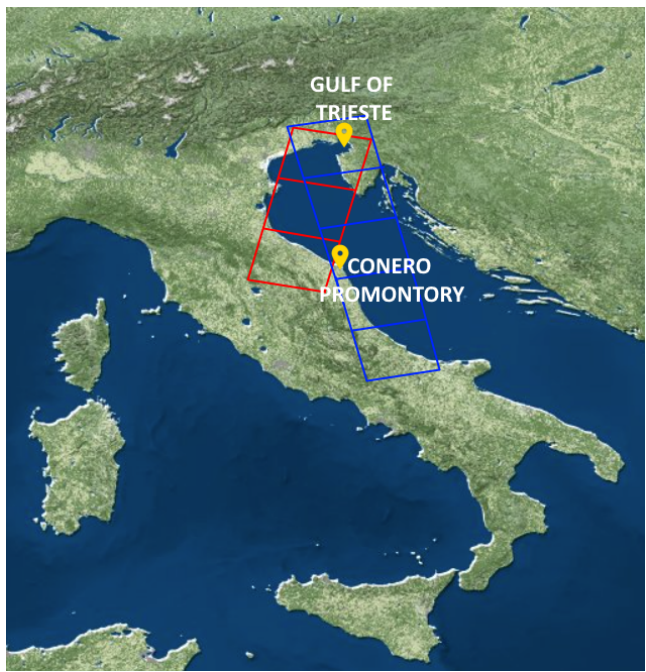
Figure 1. Location of the test site. Ascending and descending SAR acquisitions are highlighted by blue and red lines respectively. Placemarks show the location of the Gulf of Trieste and the Conero Promontory. Original images from